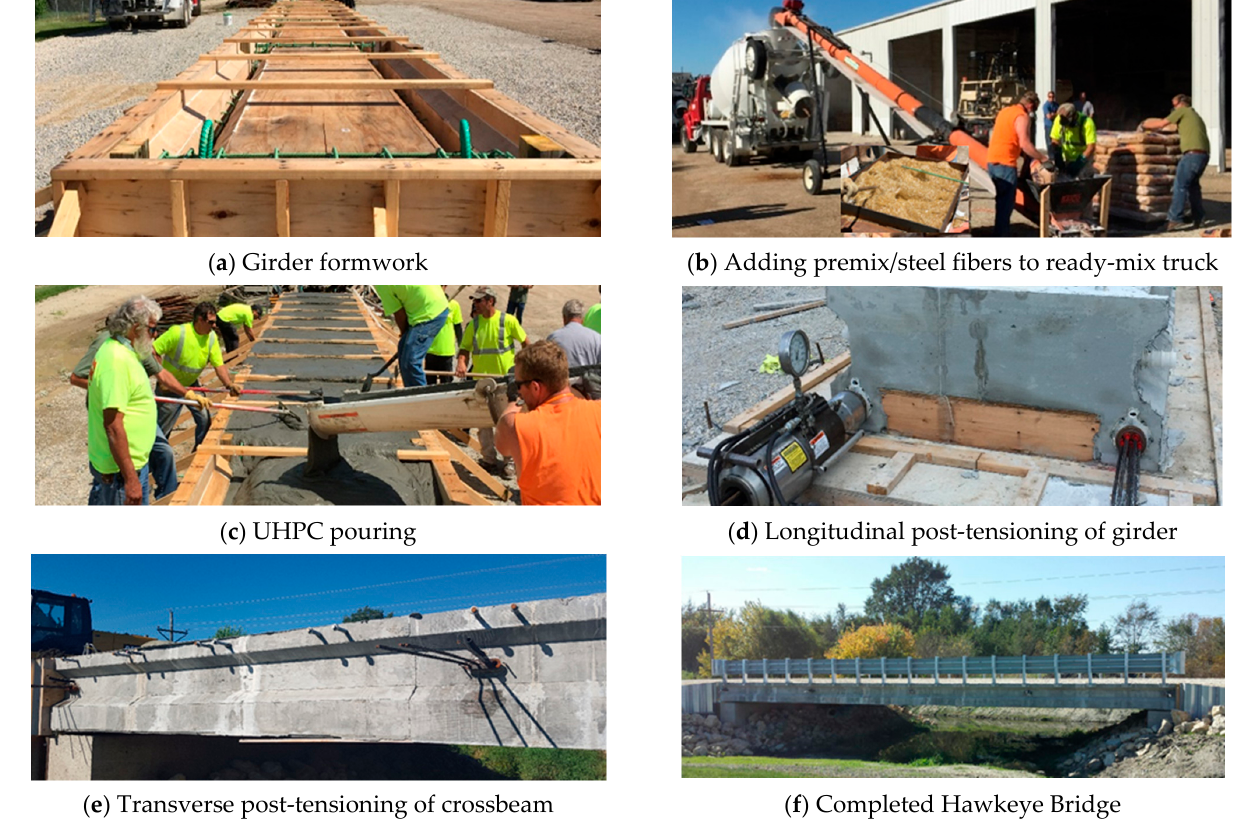
Figure 8. UHPC mixing, pouring, and construction process of Hawkeye Bridge.